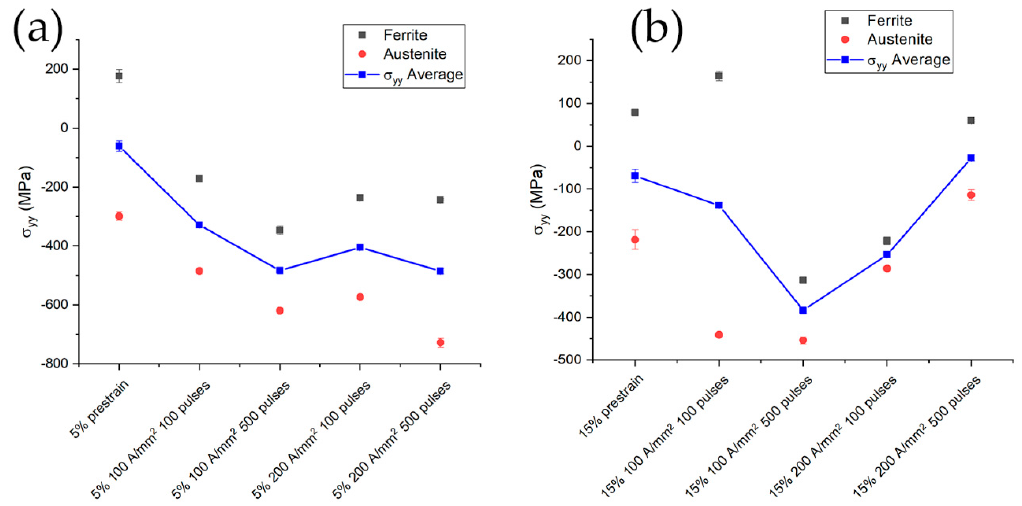
Figure 17. Evolution of longitudinal residual stresses in austenite (red circles), ferrite (black squares) and their average (blue thick line) for specimens prestrained and electropulsed at ( a ) 5% and ( b ) 15%.